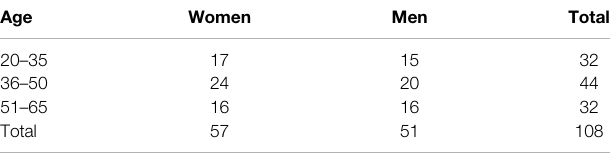
TABLE 1 | Distribution of participants in the study, by age range, and sex.